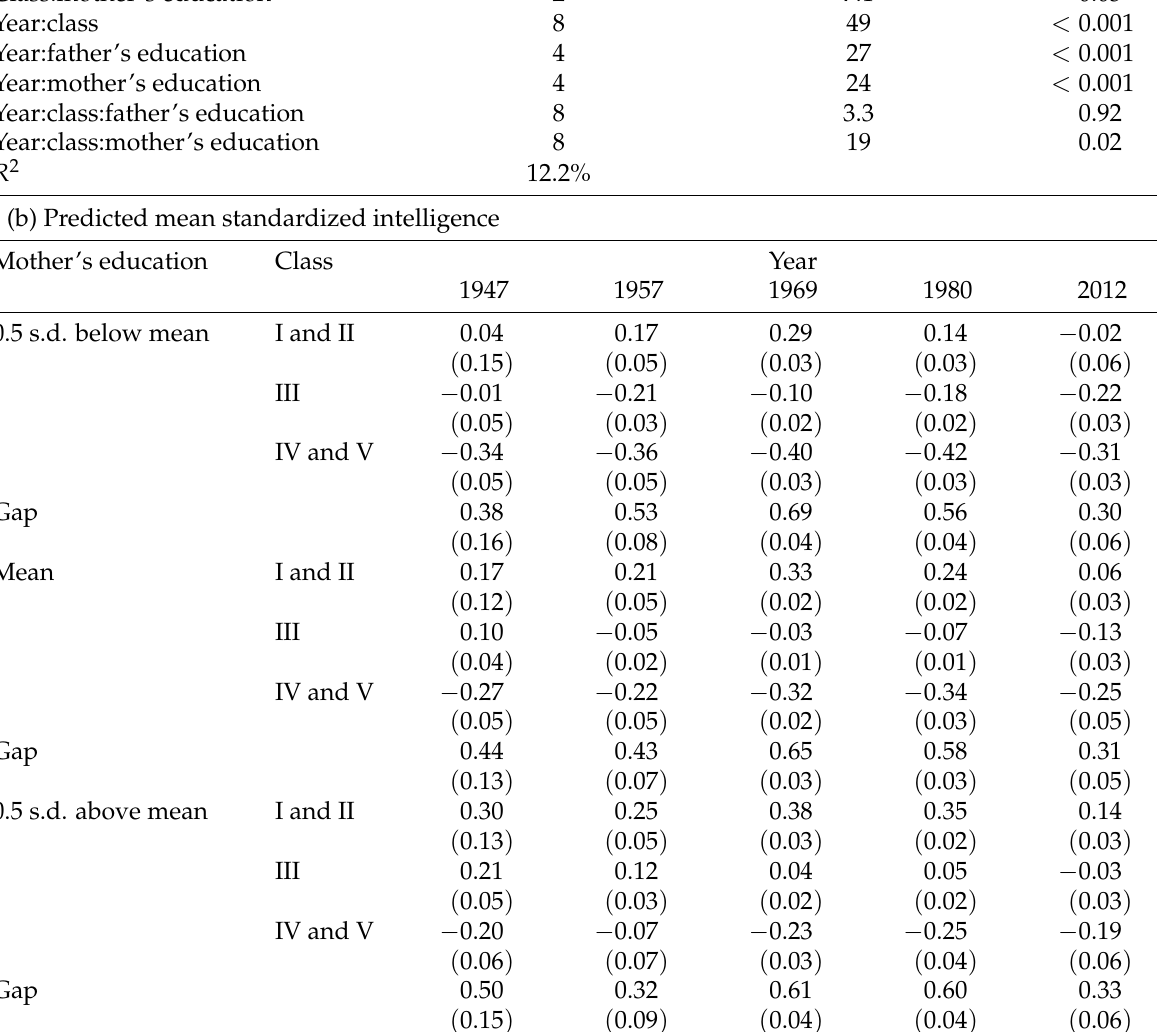
class or parental education are omitted. Standard errors of individual means are in brackets below the means. “Gap” means classes I and II minus classes IV and V. “s.d.” means standard deviation.